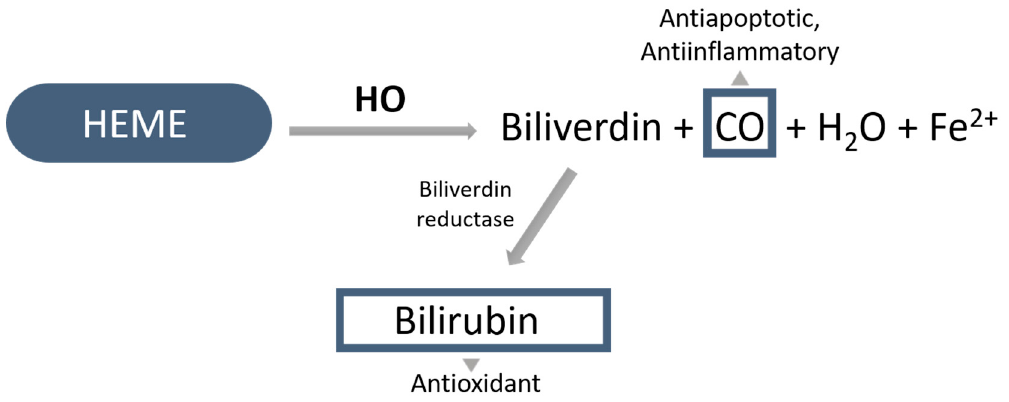
Figure 2. Activity of heme oxygenase; HO: heme-oxygenase, CO: carbon monoxide, Fe 2+ : ferrous iron. CO, through connecting the p38 mitogen-activated protein kinase (MAPK), displays an antiapoptotic, cytoprotective effect in endothelial cells [14]. In addition, it also possesses anti-inflammatory properties by modulating transcription factors and inflammatory pathways [15]. The accumulated CO in the tissues can reduce the production of inflammatory mediator molecules such as interleukin-6 (IL-6), tumor necrosis factor-alpha (TNF- α ), and interleukin-1 β , besides its anti- inflammatory responses by increasing the expression of anti-inflammatory IL-10 [16].